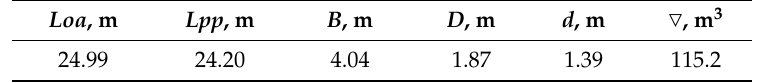
Figure 1. Self-propulsion test of a large-scale ship model at sea. Table 1. Main parameters of the large-scale ship model.